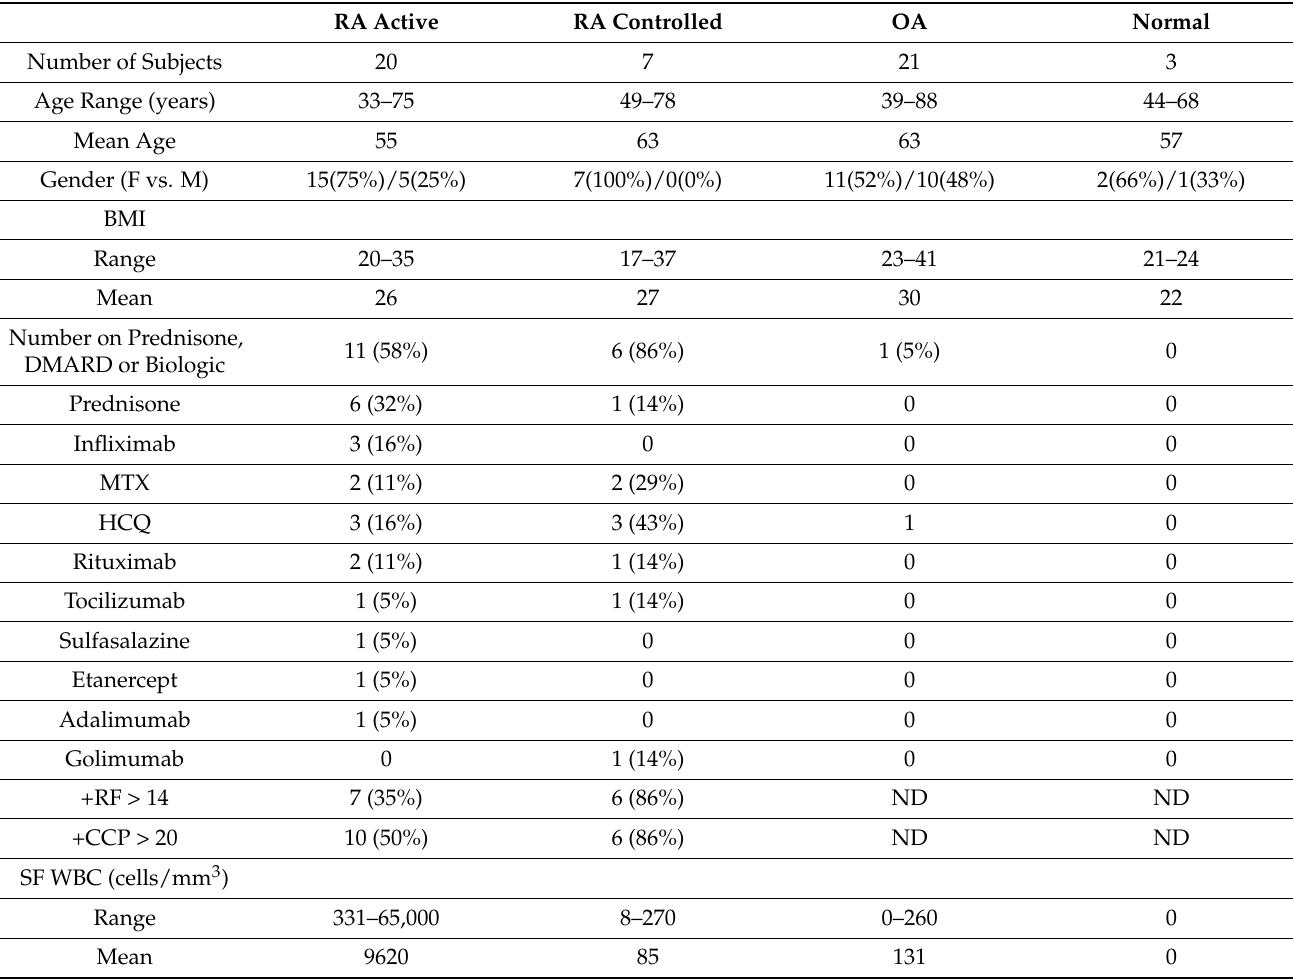
Table 1. Demographics and immunomodulatory drug use among patients with RA and OA as well as normal subjects. RA Active RA Controlled OA